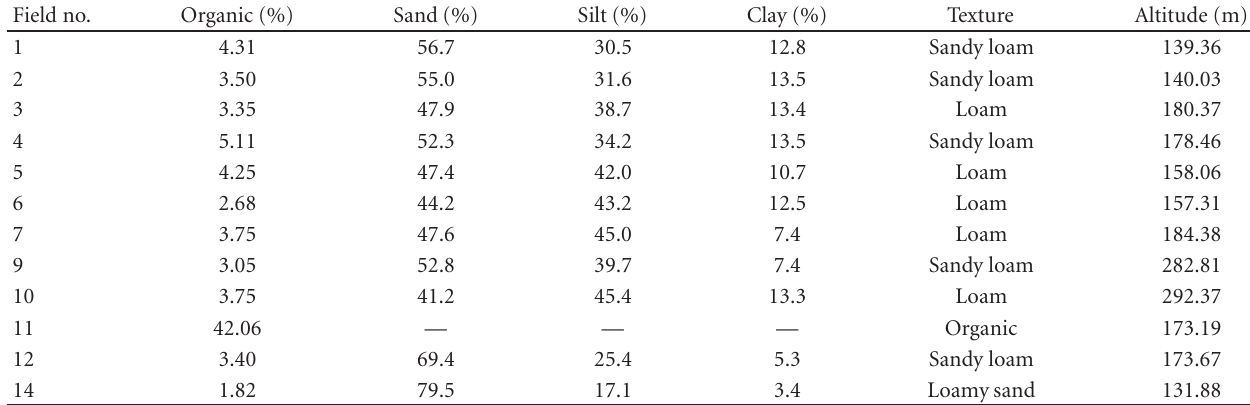
Table 2: Soil textures and attributes of the 12 fields selected as training/validation sites. Field